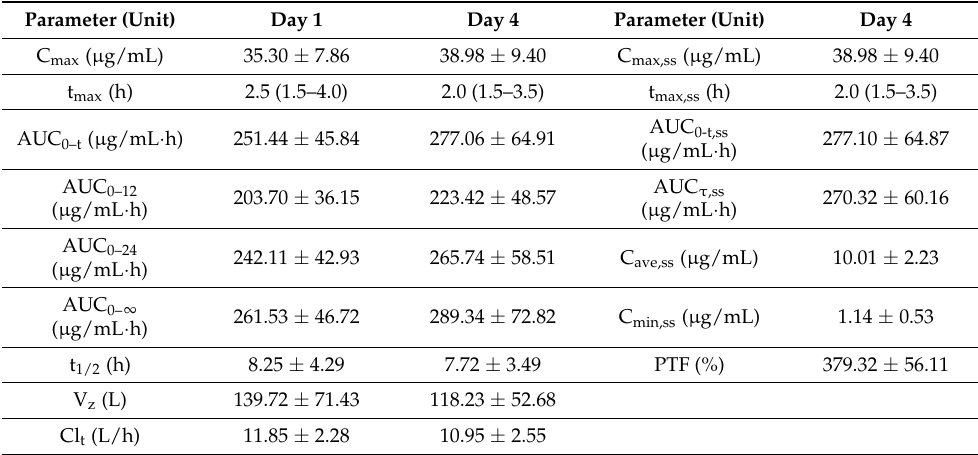
Table 2. Pharmacokinetic parameters of plasma fosfomycin measured and calculated on Days 1 and 4 after one and two consecutive doses of fosfomycin trometamol to healthy subjects (N = 24).